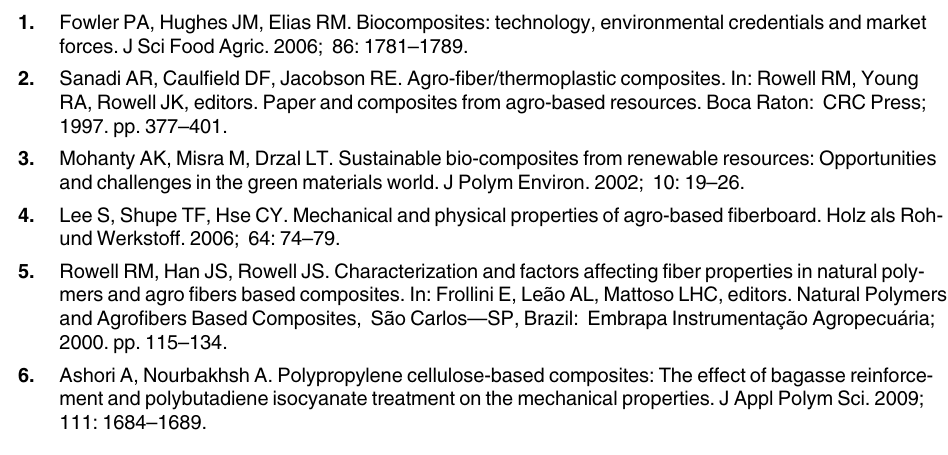
S1 Table. Correlations between agronomic, fiber compositional and composite perfor- mance traits in 50 selected RG10 x OX948 recombinant inbred lines (RILs) in different